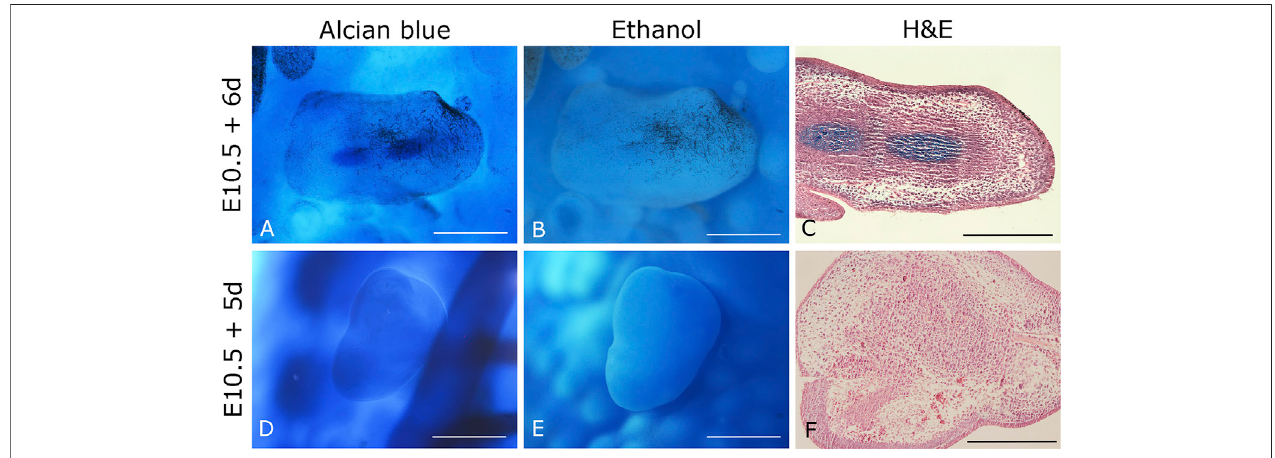
FIGURE 1 | Chimeric mouse-chicken recombinant limbs. (A – C) Six-day recombinant limbs. Limb bud mesodermal cells from 10.5 dpc mouse embryos were assembled in chicken ectoderms. (D – F) Five-day recombinant limbs. Limb bud mesodermal cells from 10.5 dpc mouse embryos were ensembled in chicken ectoderms. Chicken ectoderms and host embryos were obtained from the 22 HH stage. Data represent two independent experiments. Scale bar 100 µm.